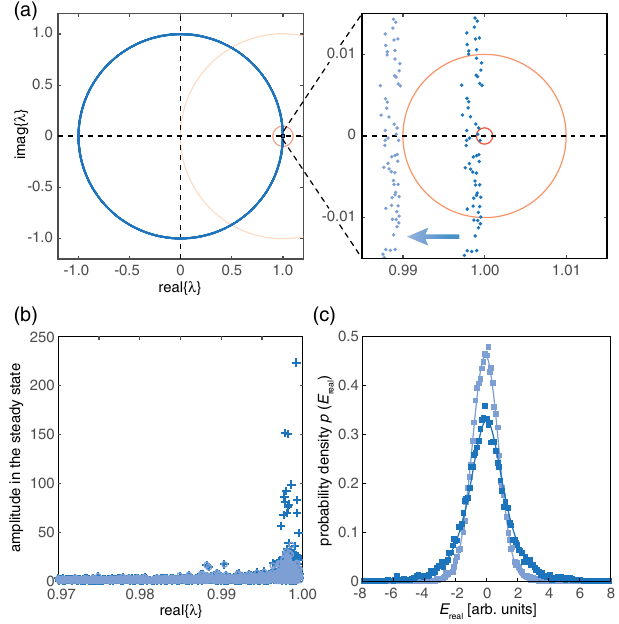
FIG. 9. Eigenvalues and evolution coefficients in the steady state for a small domain ( N L ¼ 100 , N W ¼ 31 ). (a) The eigen- values λ (blue dots) are situated close to a circle of radius 1 in the ˆ M is almost unitary. complex plane, since the evolution matrix Additional losses reduce the radius of this circle (light blue dots in the inset). Red circles of increasing intensity illustrate incre- ments of the function 1 = ð 1 − λ Þ by an order of 10 around its pole. (b) Moduli of the amplitudes of the eigenvectors in the steady state versus the real part of the eigenvalues. For negligible losses, a few coefficients exceed all others (blue crosses); hence, few respective eigenvectors dominate the steady state. For increasing losses this effect is damped (light blue circles). (c) Comparison of the field statistics of the superposition in the steady state for negligible losses (blue squares, solid line is fit with sech function) and additional losses (light blue squares, solid line is fit with